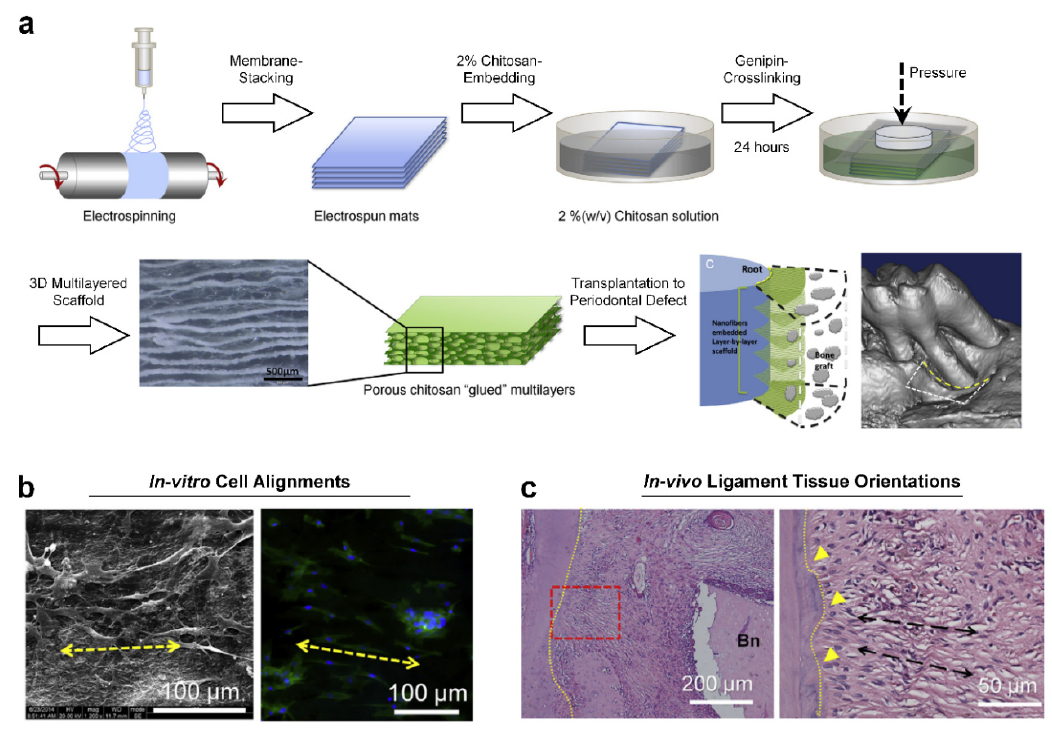
Figure 6. The electrospun nano-/micro-fibrous 3D scaffolds for engineered periodontal ligament (PDL) orientations. ( a ) The schematic illustration shows 3D stacked scaffold creation using the electrospinning fabrication, and chitosan solution was facilitated for 3D structures with the genipin crosslinking agent. For in vivo transplantation, the periodontal defects around the mesial root of the first molar tooth were surgically created in a rat model. ( b ) In vitro, the seeded cells showed polarized cytoskeletons and morphological alignments using scanning electron microscope (SEM) and fluorescence microscope images (Blue: DAPI and Green: actin). The arrowed yellow-dash line indicates directions of aligned cells. ( c ) By the hematoxylin and eosin (H&E) staining method, PDL-like fibrous connective tissues were formed with the perpendicular orientations to the tooth-root surface in two months. The yellow triangles indicate the limited but newly formed cementum-like tissue layer and the arrowed back-dash lines indicate the orientations of fibrous tissues. (Bn: Bone). Adapted with permission from the reference [51].